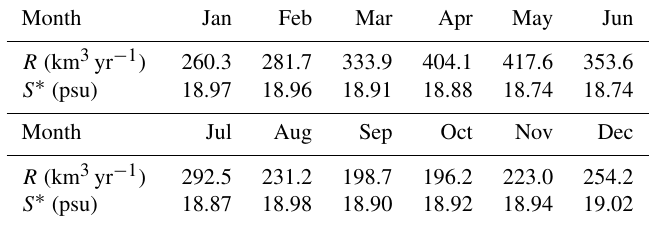
Table 1. Monthly Black Sea river discharge ( R ) and salinity relaxation values ( S ∗